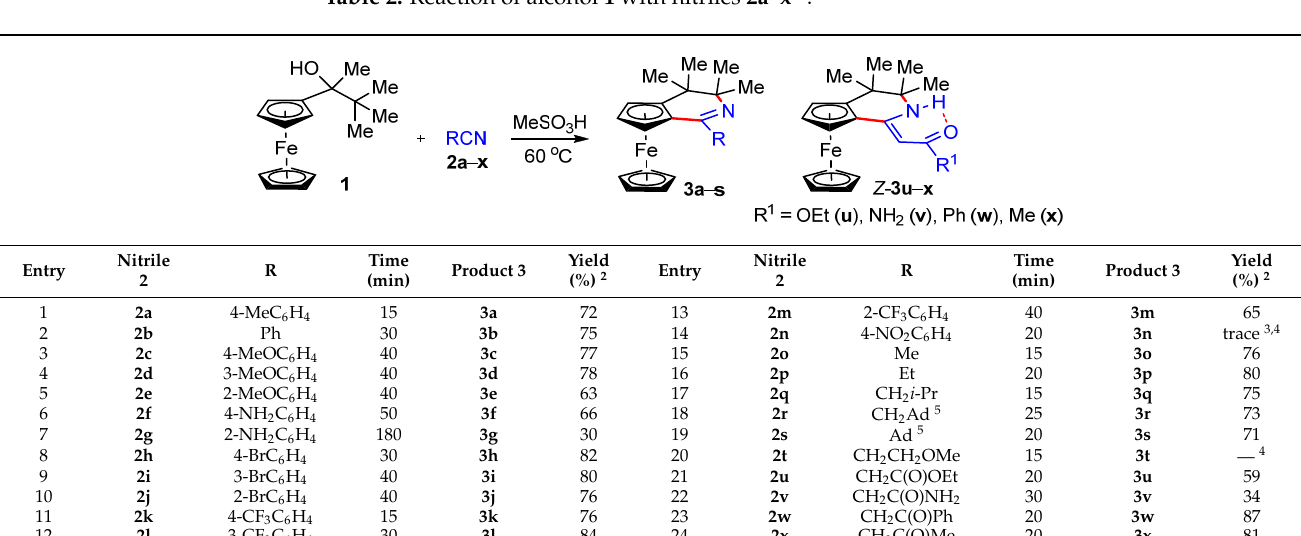
Table 2. Reaction of alcohol 1 with nitriles 2a ‒ x . 1